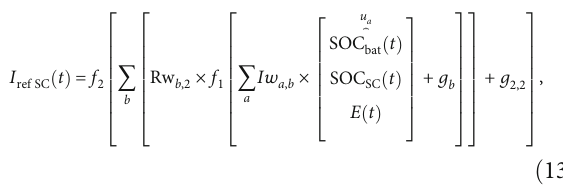
Table 3: PV system